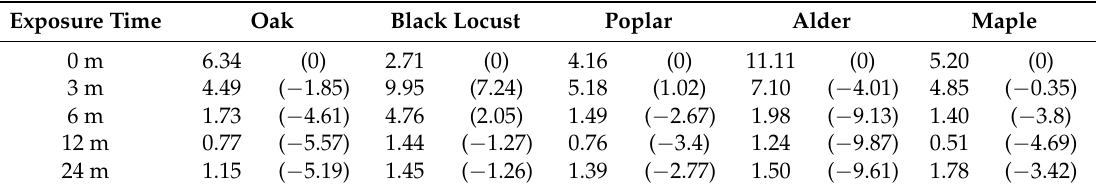
Table 5. Exposure time-dependence of a * value (chromaticity differences ∆ a * are in brackets). The data represent mean values. Exposure Time